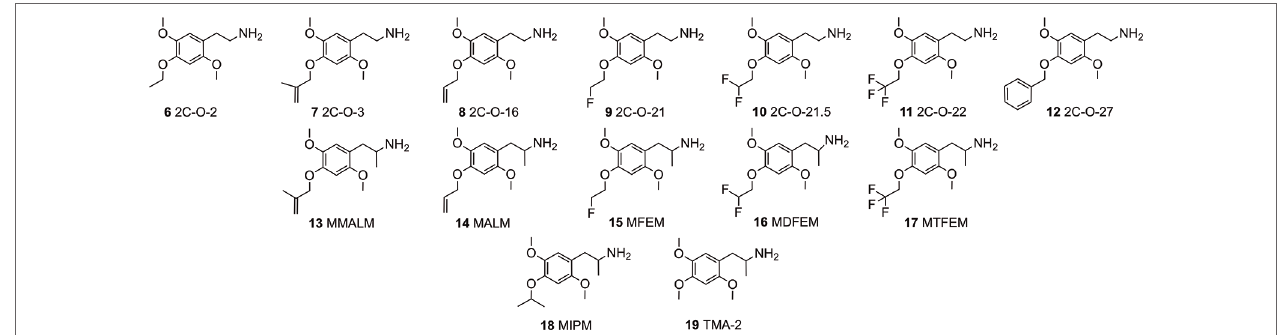
FIgURe 2 | Chemical structures of 4-alkyloxy-2,5-dimethoxyphenethylamines (2C-O derivatives) and 4-alkyloxy-2,5-dimethoxyamphetamines (3C-O) examined in the investigation.